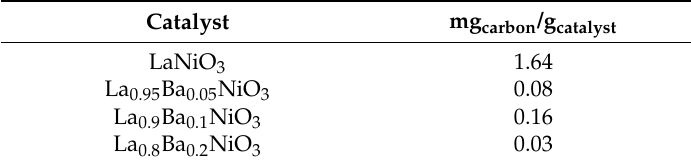
Table 1. Carbon deposited on catalysts after 20 h under reaction stream.